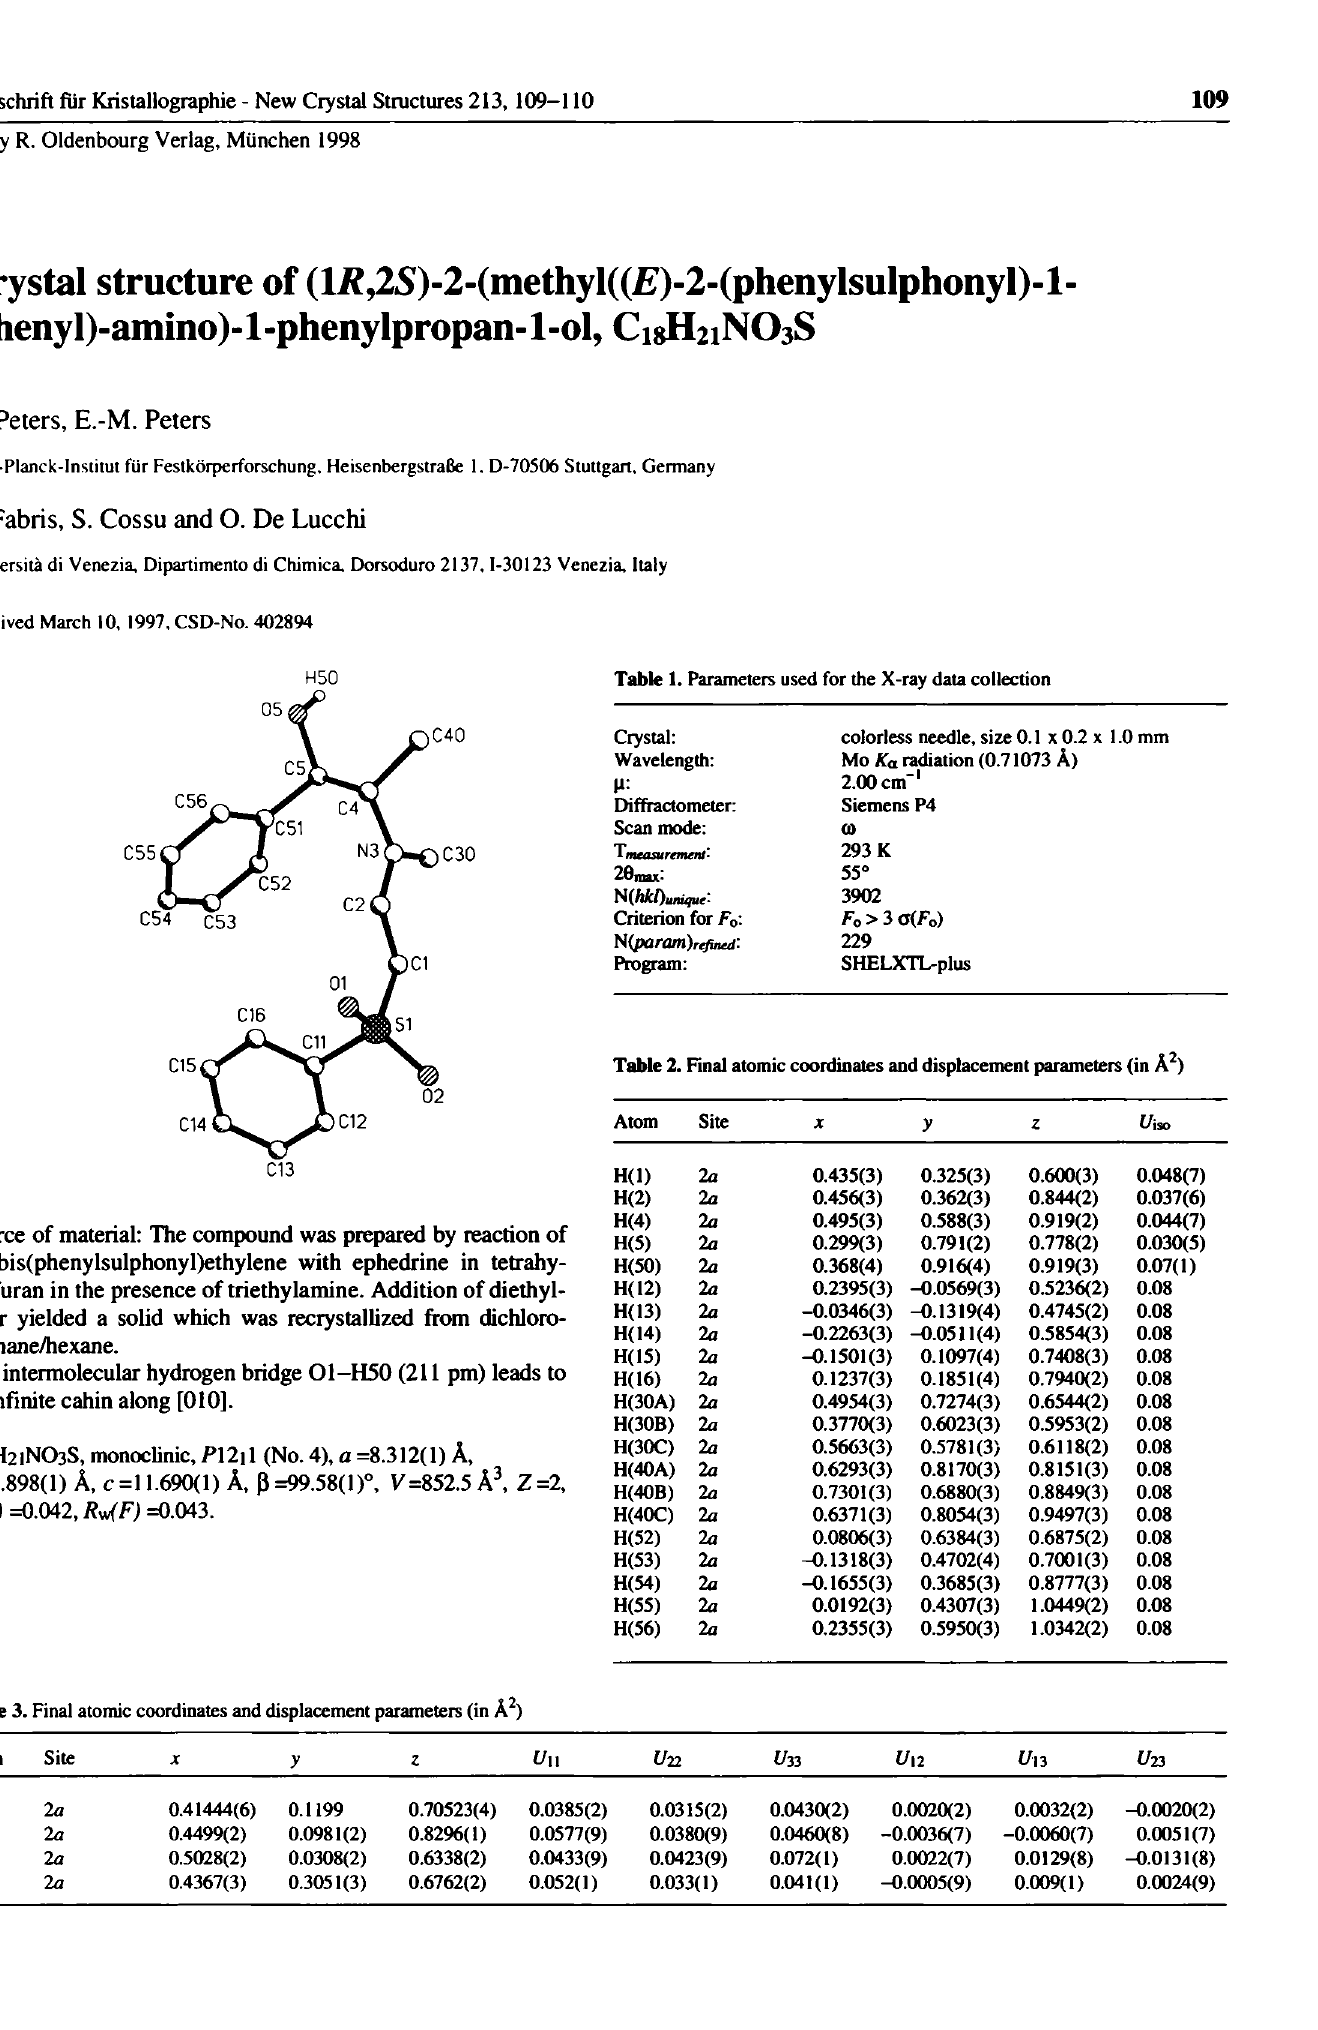
Table 3. Final atomic coordinates and displacement parameters (in Â})